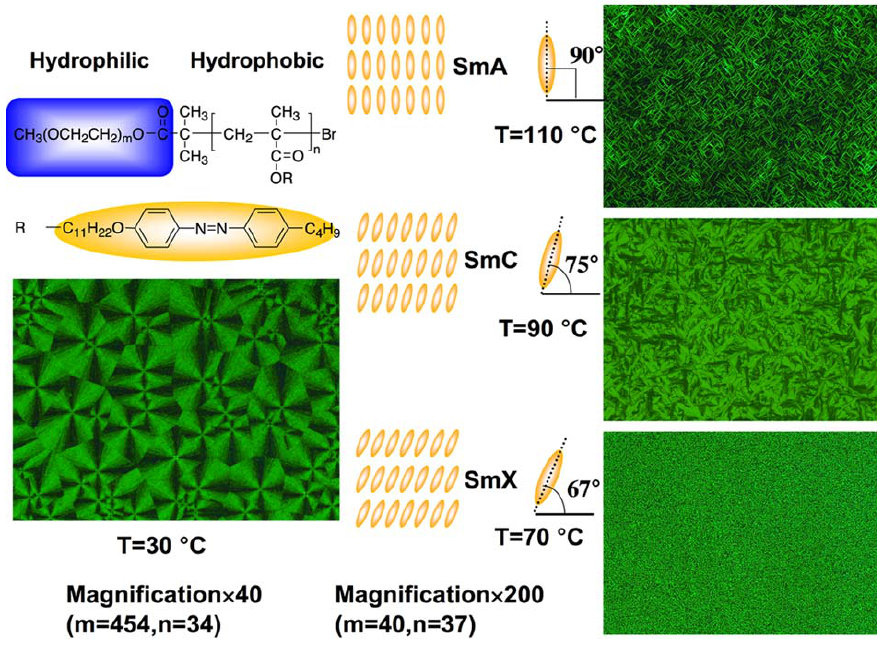
Figure 9. POM images and possible smectic LC layer structures of PEO-based